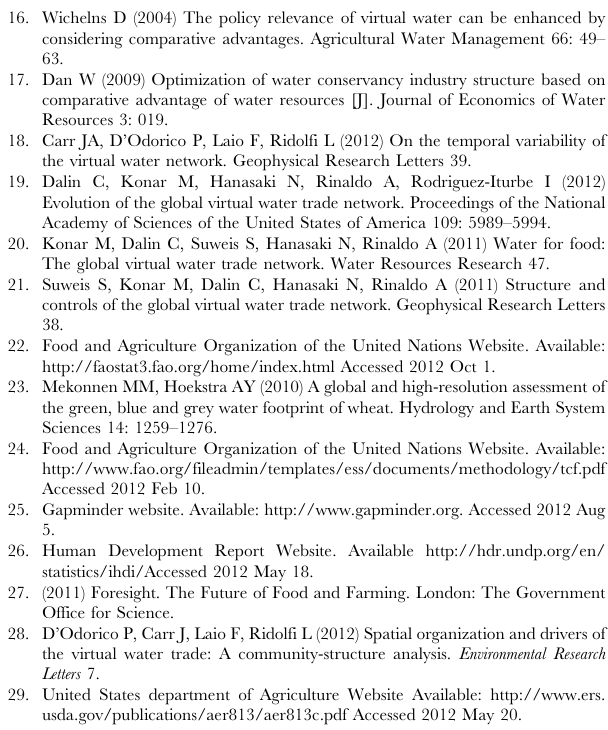
Table S1 Commodities used in this study and catego-